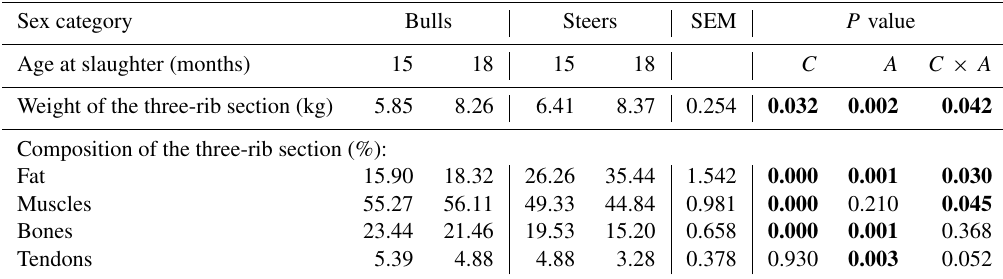
Table 3. Tissue composition of three-rib sections. Sex category Bulls Steers SEM P value Age at slaughter (months) 15 18 15 18 C A C × A Weight of the three-rib section (kg) 5.85 Composition of the three-rib section (%): Fat Muscles